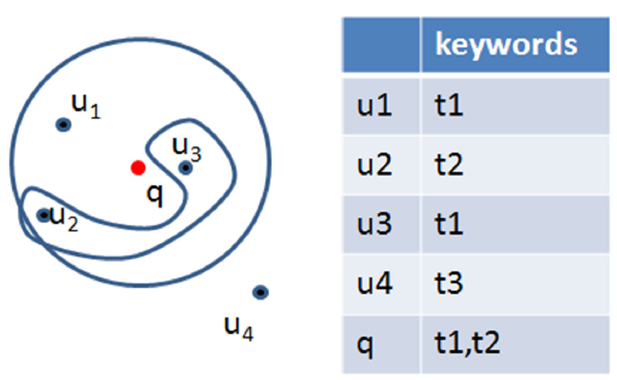
Figure 7. An example of a geosocial keyword query that considers a set of objects {u1, u2, . . . , u4} located in the places depicted by circles and associated with keywords shown in the table on the right. Query q requests a location (red circle) and a set of keywords. The query returns the set of objects {u2, u3} that minimizes the distance and contains the required keywords.